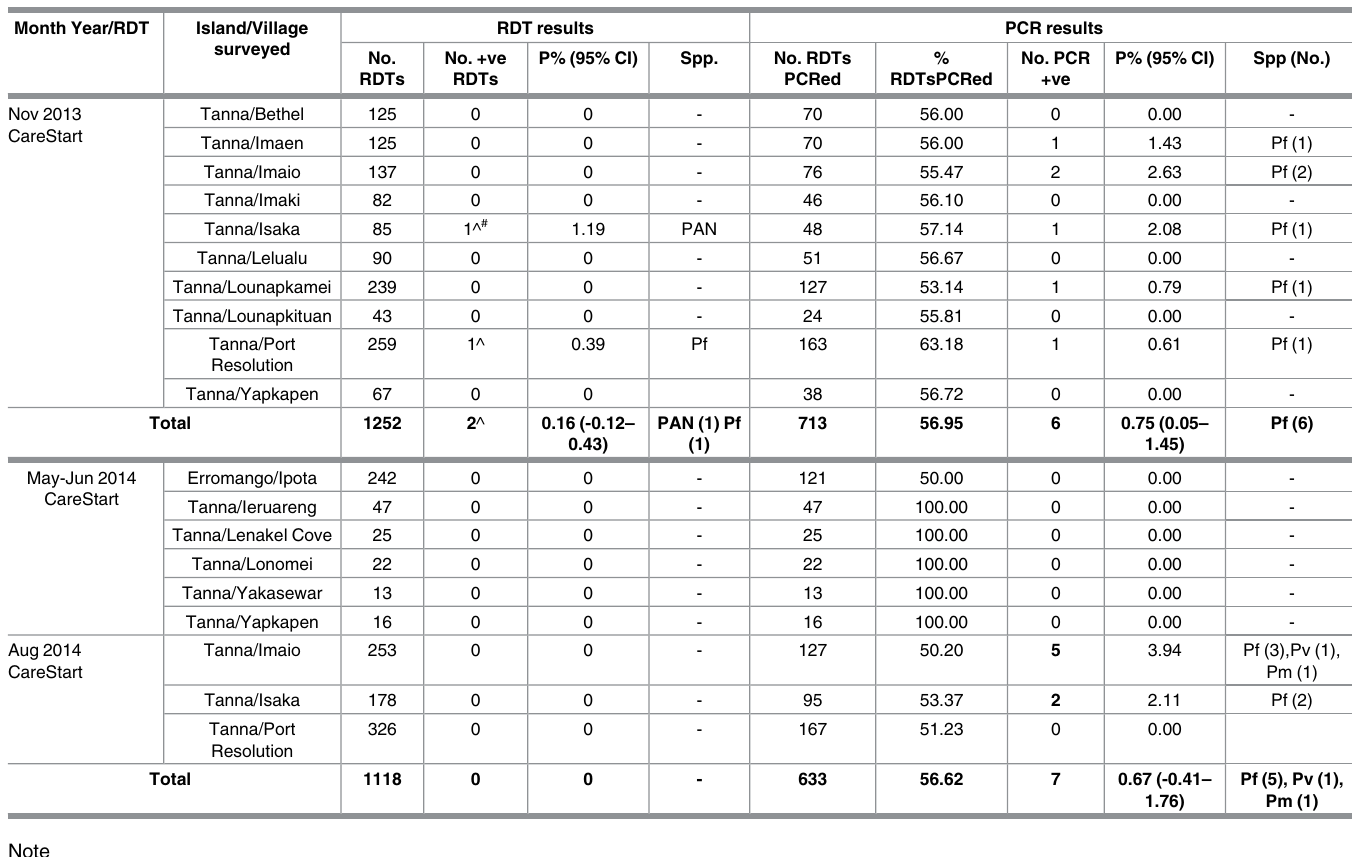
Table 1. Time, location, number of individuals tested and results of RDT and PCR from used-RDTs in Pro-ACDs conducted in Tafea Province. Month Year/RDT